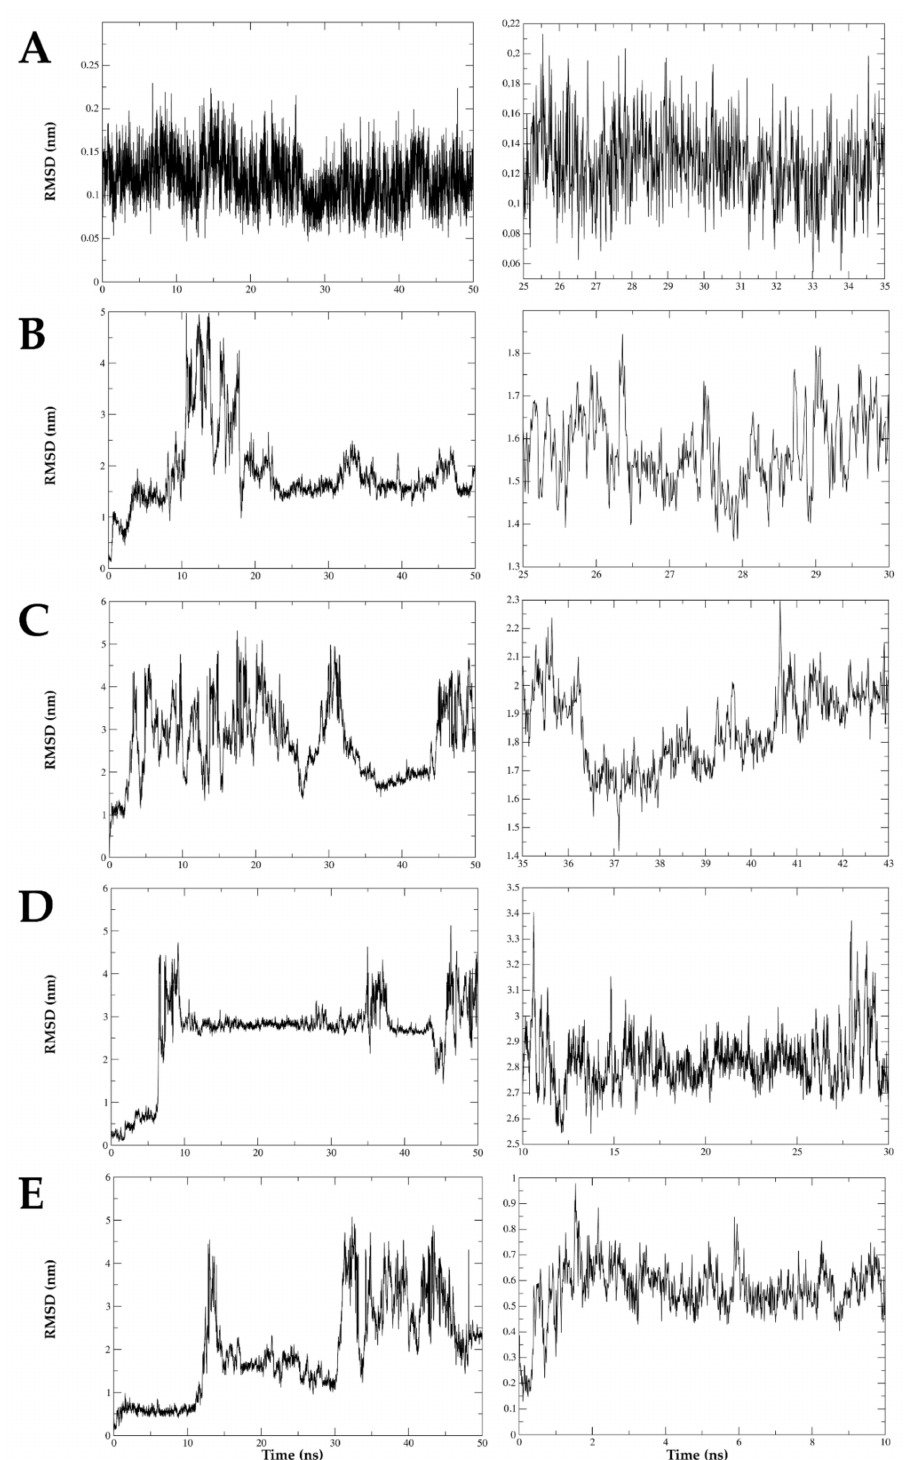
Figure 8. Complex stability by molecular dynamics. The stability of the complex formed by each compound with virucidal effect and the Domain III of DENV envelope protein was evaluated; DENV- 2 with VOAC ( A ), VOAC-OH ( B ), rupicoline ( C ) and OXO-VOAC ( D ), and DENV-1 with VOAC ( E ). The left plot indicates the complete 50 ns simulation, and the right plot indicates the site with the lowest oscillation of each simulation. The y -axis represents the root-mean-square deviation (RMSD) that represents the average oscillation of the distance between the atoms of the complex components in nanometers (nm), and the x -axis the timescale in nanoseconds (ns). The complex is considered stable if the oscillation from the initial position of the complex is below 0.3